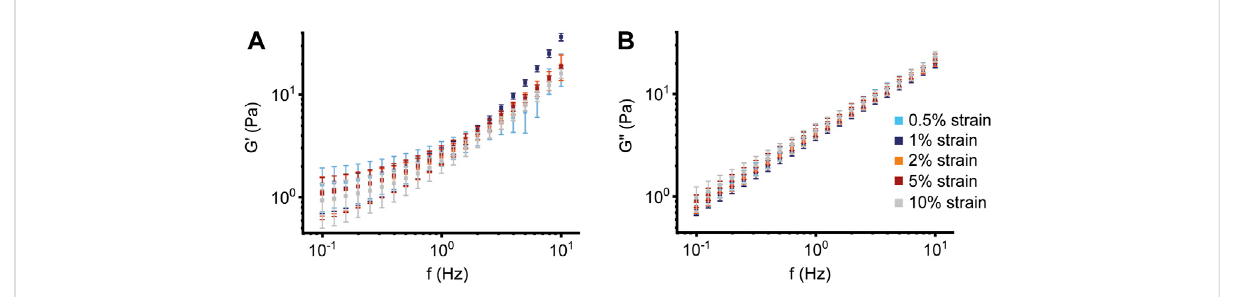
FIGURE 1 Deformationeffectofdifferentstrainamplitudes.Effect ofdifferentstrainamplitudes(0.5% – 1% – 2% – 5% – 10%)asfunctionoffrequency(Hz)on